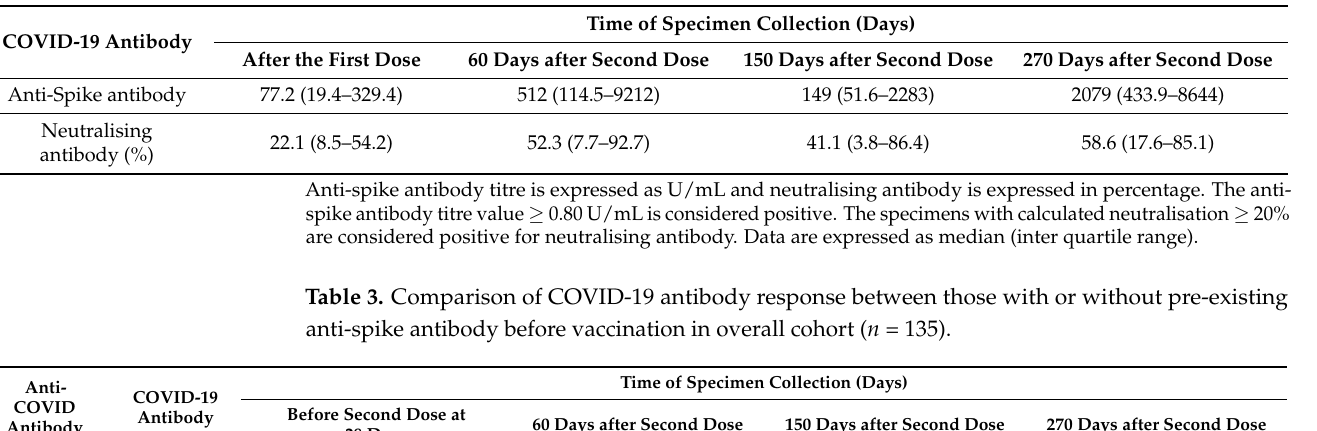
Table 2. Temporal pattern of vaccine induced COVID-19 antibody in overall cohort ( n = 135).